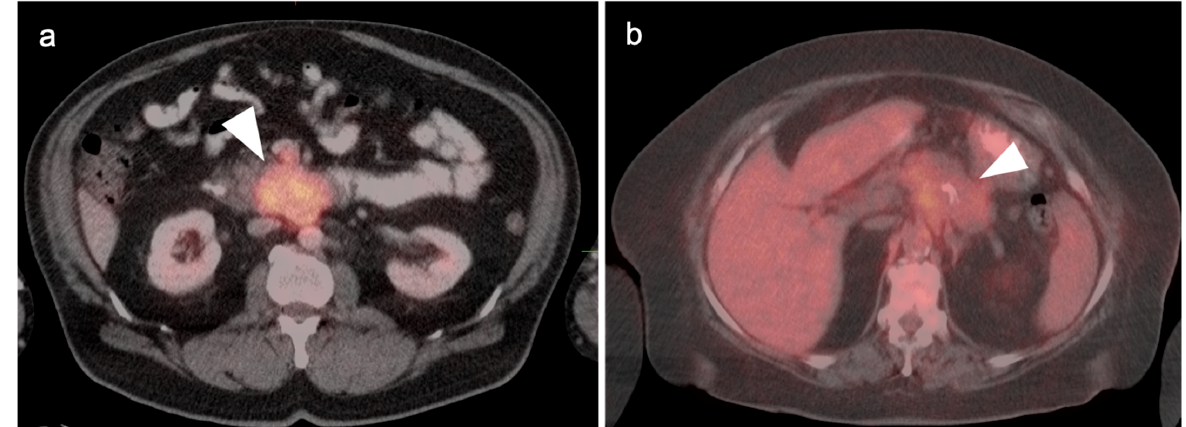
Figure 26. Variable appearance of pancreatic cancer on axial fused FDG PET-CT images in two patients. Case 1: ( a ) Intensely hypermetabolic primary tumor involving the uncinate process of the pancreas (white arrowhead); Case 2: ( b ) Mildly hypermetabolic tumor involving the body of the pancreas (white arrowhead). Both tumors are solid in appearance on CT, and not grossly cystic, and both were adenocarcinoma.